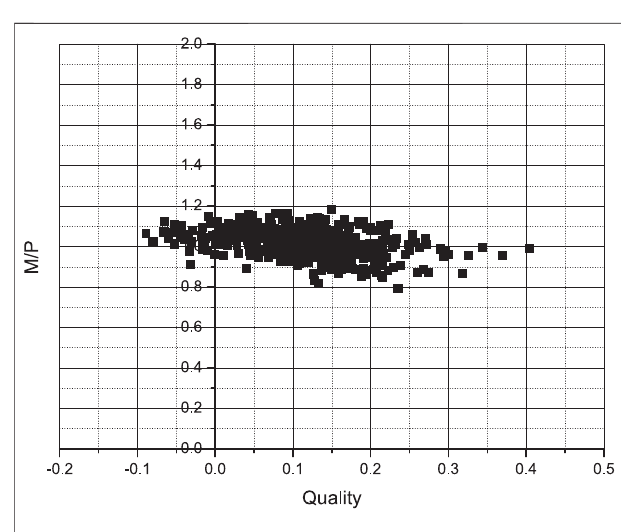
FIGURE 15 | M/P as a function of local